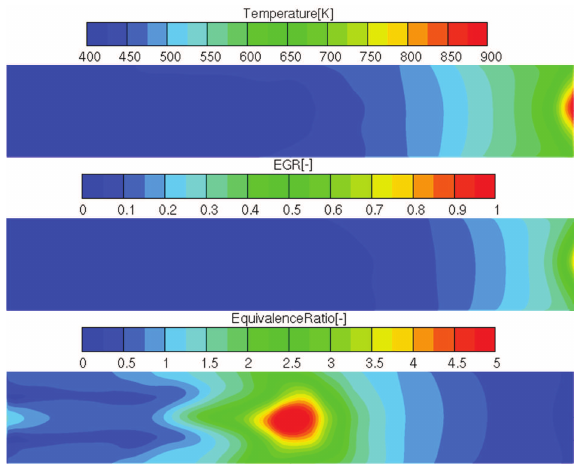
Fig. 7. Results of temperature, EGR fraction and equivalence ratio in cross-section along the